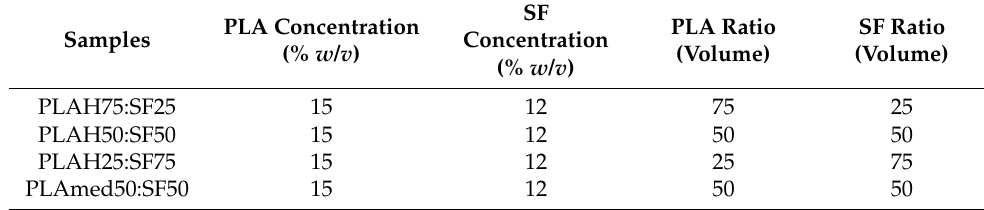
Table 2. PLA/SF electrospun